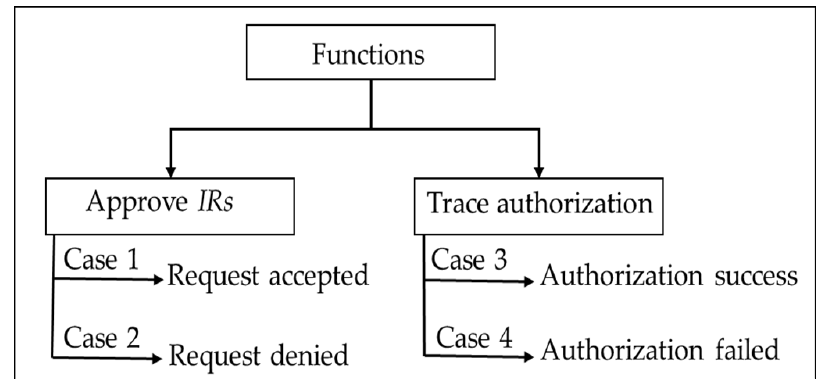
Figure 5. PCAC-SC validating functions and testing cases.